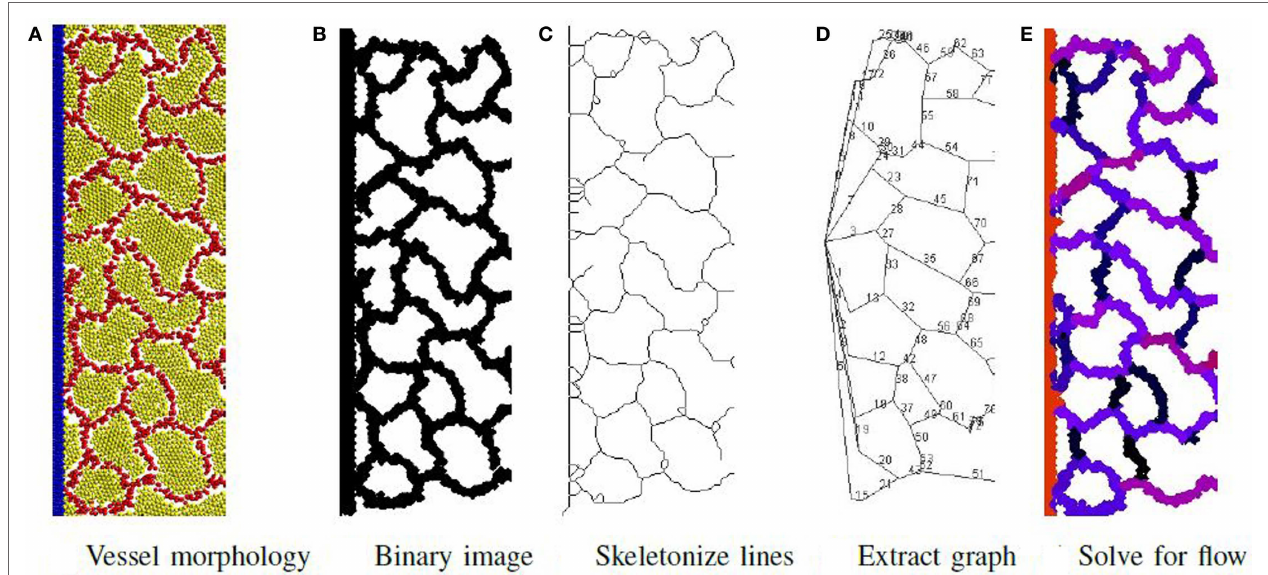
FIGURE 6 | Phase II: initially, a network of pipes is extracted from the vessel morphology in steps (A–D) . Then, the flow rate of material through each vessel is determined and illustrated (E) using a color map to signify flow rate magnitude. Red is highest flow rate and black is the